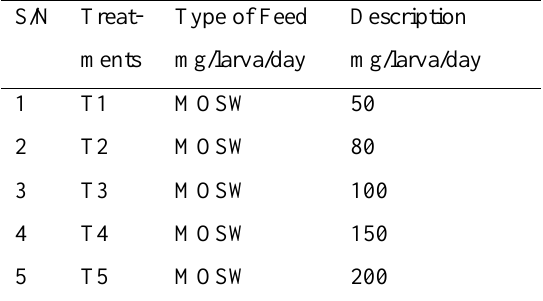
Table 1 Formulations and compositions of